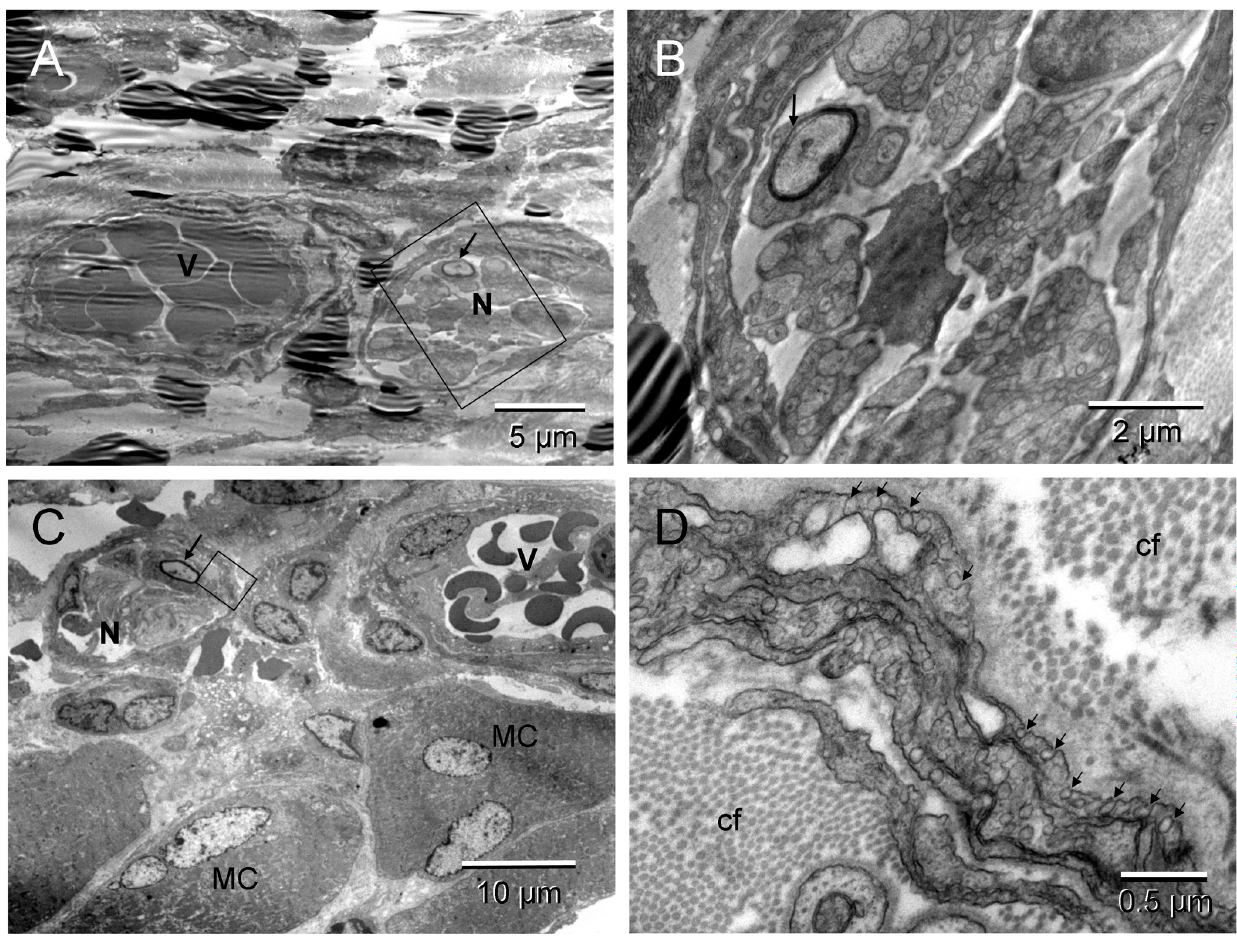
Figure 4. Coordinated morphogenesis of blood vessels (V) and peripheral nerves (N). Two neuro-vascular pairs. The upper pair was less mature; the boxed area of the nerve in [ A ] (enlarged in [ B ]) showed incomplete myelination of the neuron (arrows). The pair located next to the muscle cells (MC) [ C ] appeared more mature; the myelination of one neuron was completed (arrow). Morphology of the erythrosomes surrounded by endothelium was also more mature in [ C ]. The boxed area, enlarged in [ D ], featured abundant caveolae (arrows) of the multilayered neurothelium and difference in thickness of the collagen fibers (cf) between those in endoneurium (thinner) and in surrounding ECM (thicker) [ D